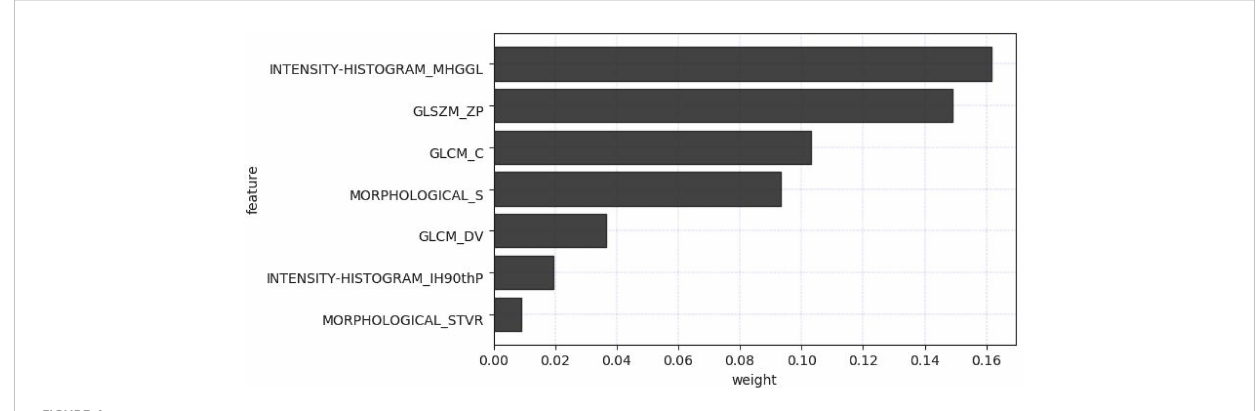
FIGURE 4 Filtered feature names and its weight